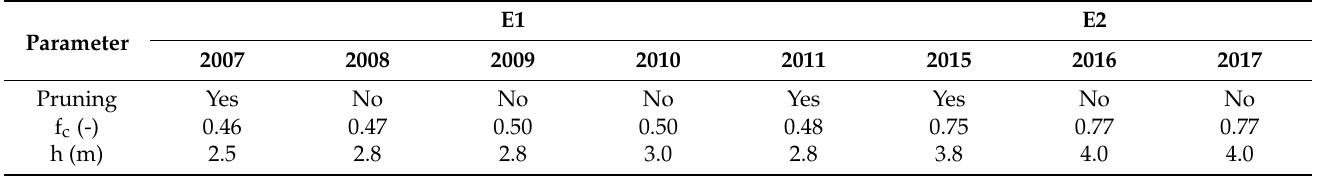
Table 6. Measured fraction of the ground cover (f c ) and tree height (h) during the E1 and E2 seasons. E1